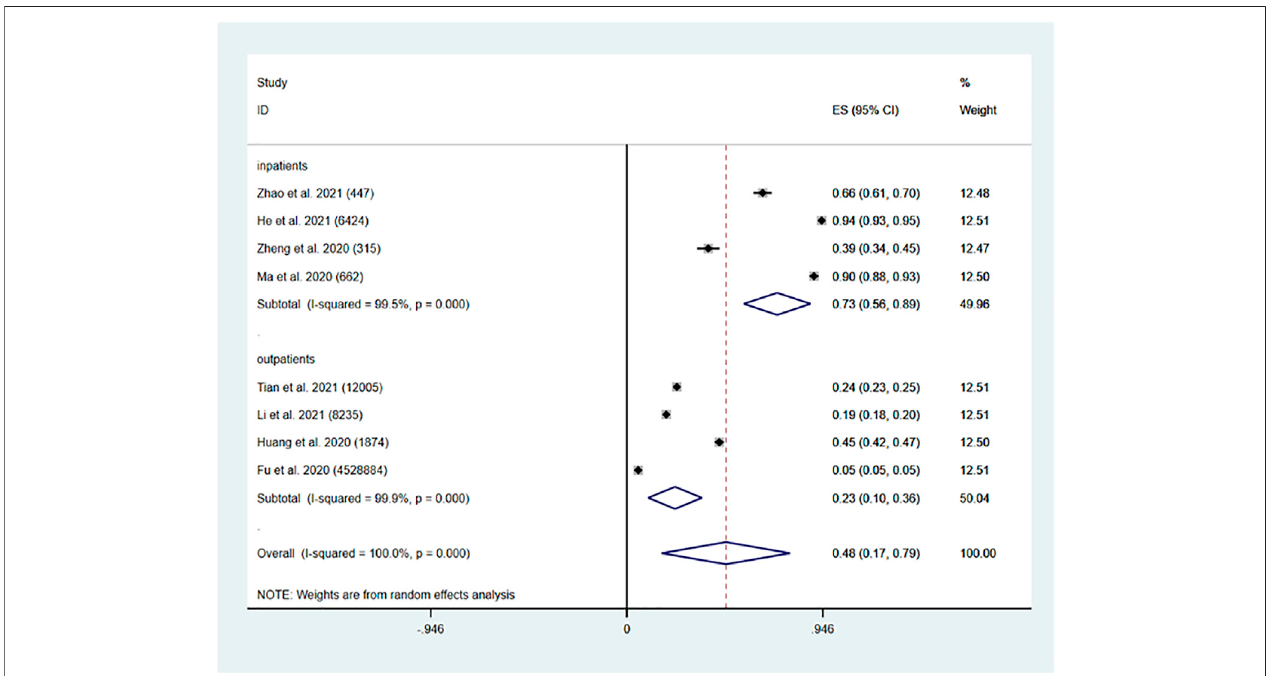
FIGURE 2 | Prevalence of polypharmacy in the Chinese older